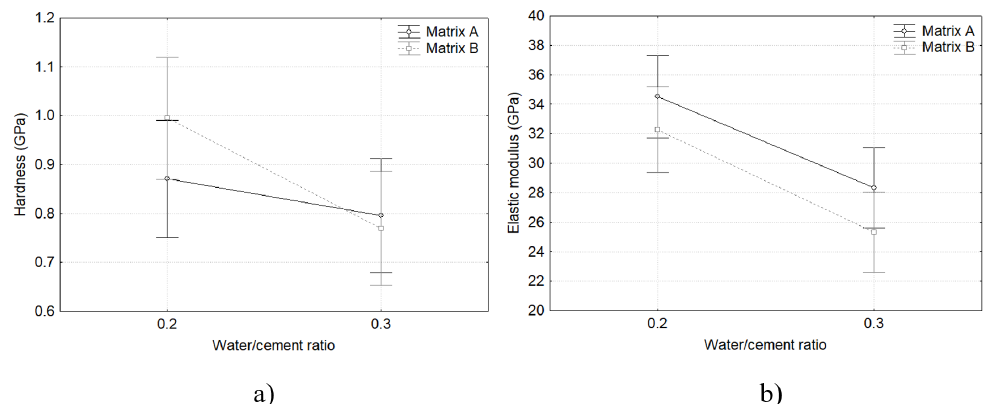
Figure 1. Results of hardness (a) and elastic modulus (b) obtained by the nanoindentation technique applied to cement pastes with w/c ratios of 0.2 and 0.3 without steel microfibers, varying the load from 100 mN (matrix A) to 50 mN (matrix B).